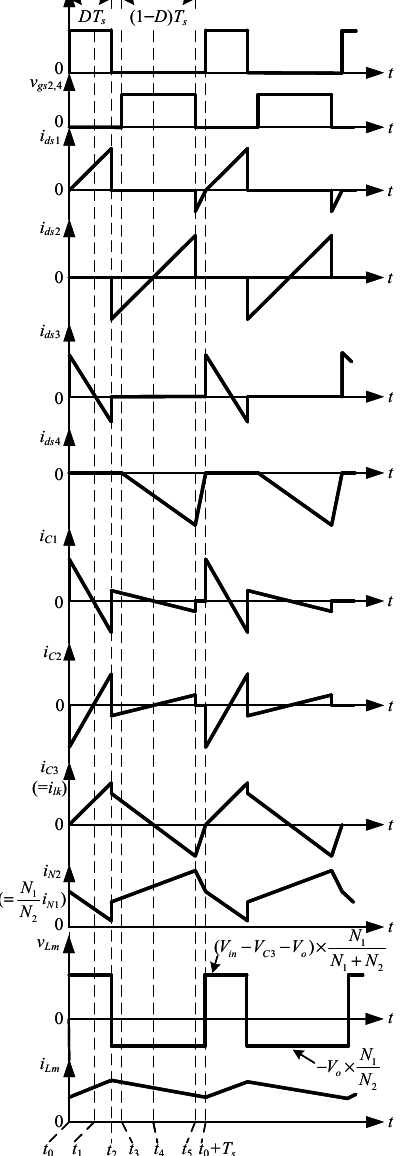
Figure 3. Key waveforms relevant to the proposed converter operating.